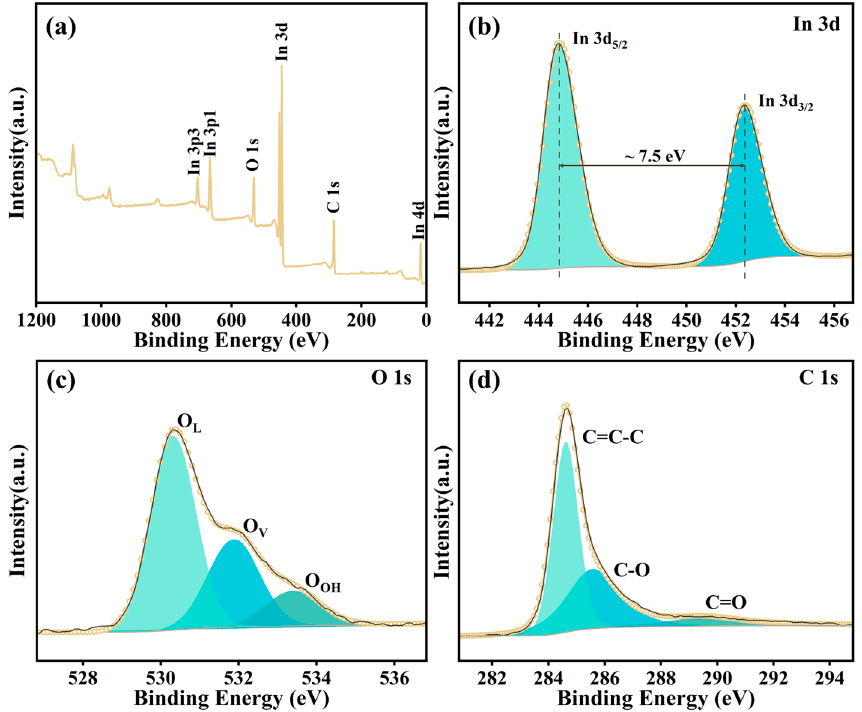
Figure 5. ( a ) Survey XPS spectra of 5-rGO/In 2 O 3 , ( b ) XPS spectrum of In, ( c ) XPS spectrum of O, and ( d ) XPS spectrum of C.